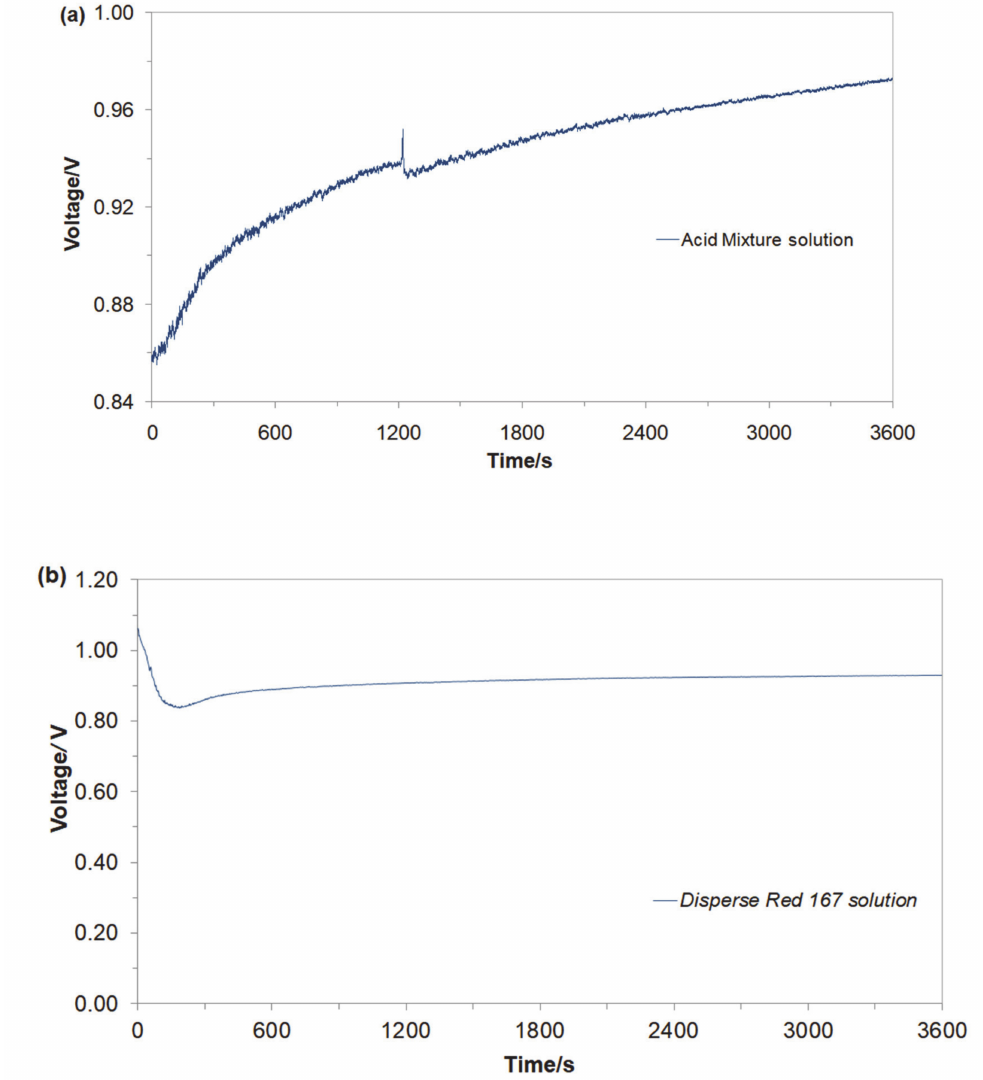
Figure 2. Recorded values of open-circuit voltages for Cu / Al alloy galvanic cell, derived for freshly-prepared, aerated Na 2 SO 4 -based solutions, in the presence of ( a ) Acid Mixture and ( b ) Disperse Red 167 dyes, both at the concentration of 50 mg dm − 3